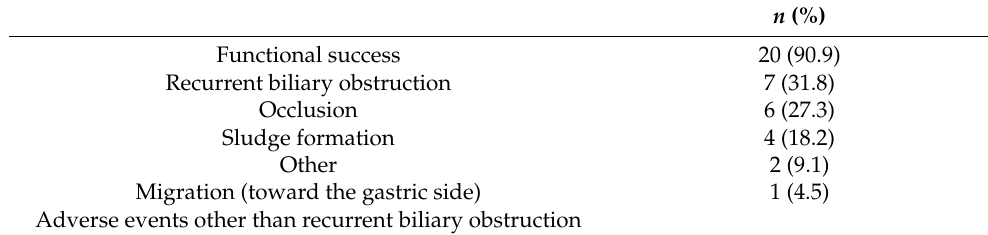
Table 3. Clinical